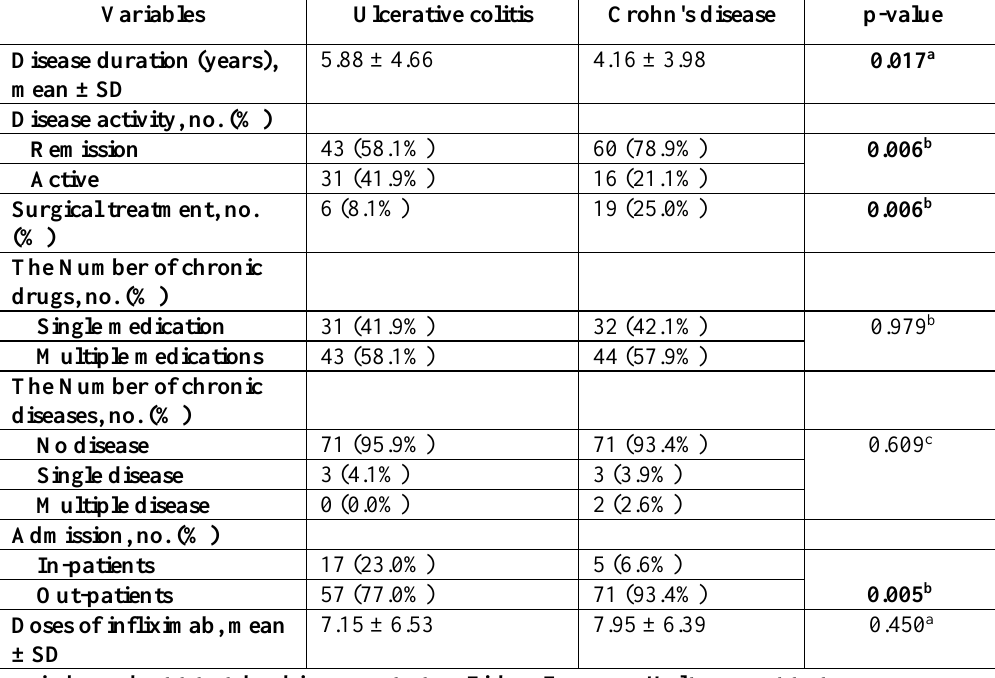
Table 2. Comparison of disease haracteristics between both types of IBD